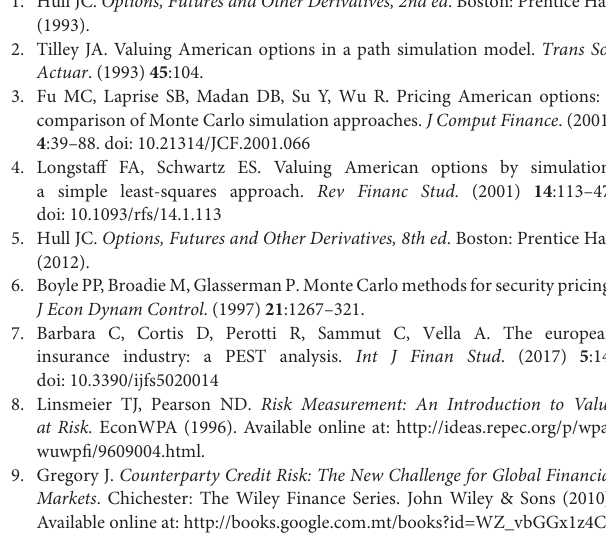
the positive skewness of outcomes, hence increasing the mean and reducing large percentile values. This justifies the results of EPE and PFE respectively of the two valuation methods when compared to the limits set in Equations (4) and